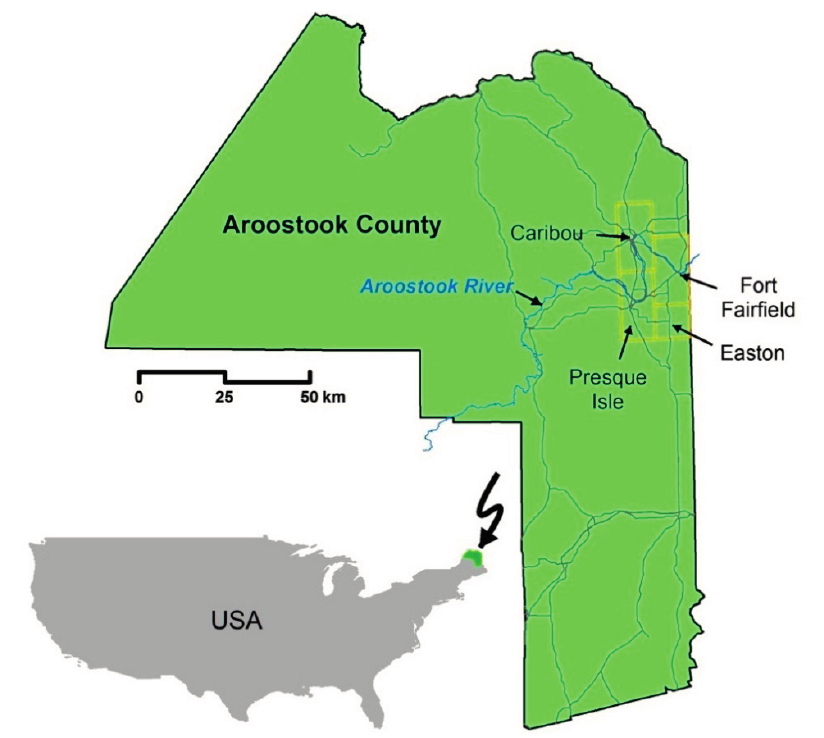
Figure 1. Map showing location of the study area—the four townships of Presque Isle, Caribou, Fort Fairfield, and Easton in the Aroostook River Valley of Aroostook County of northern Maine,